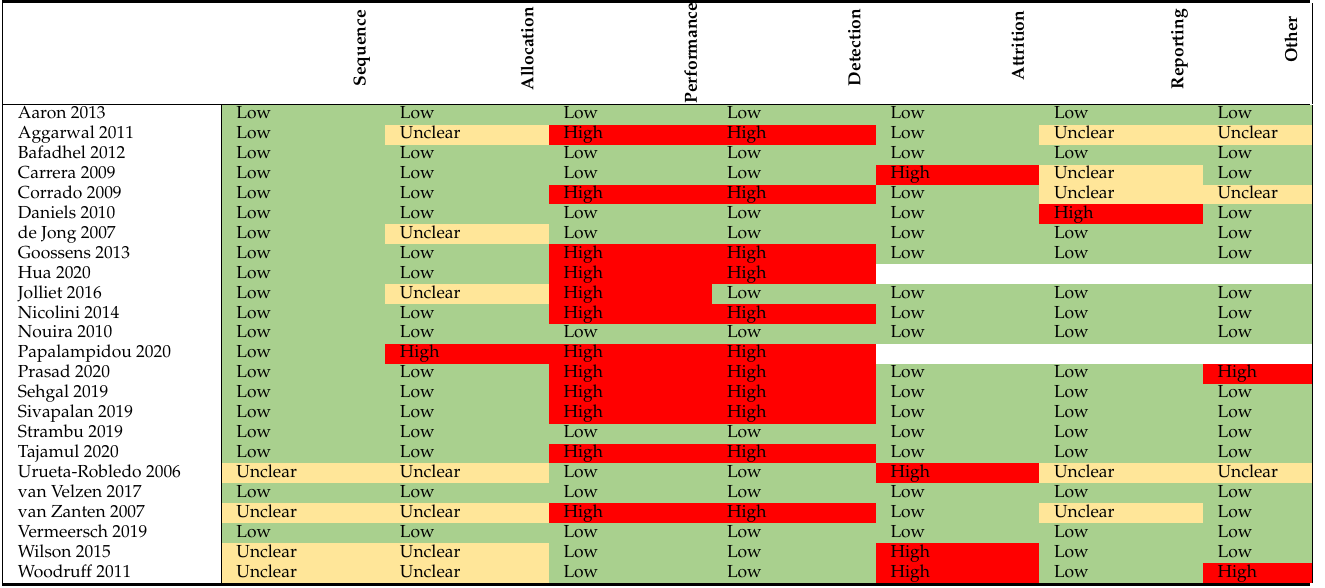
Table 2. Risk of bias of RCTs reporting composite outcome measurement